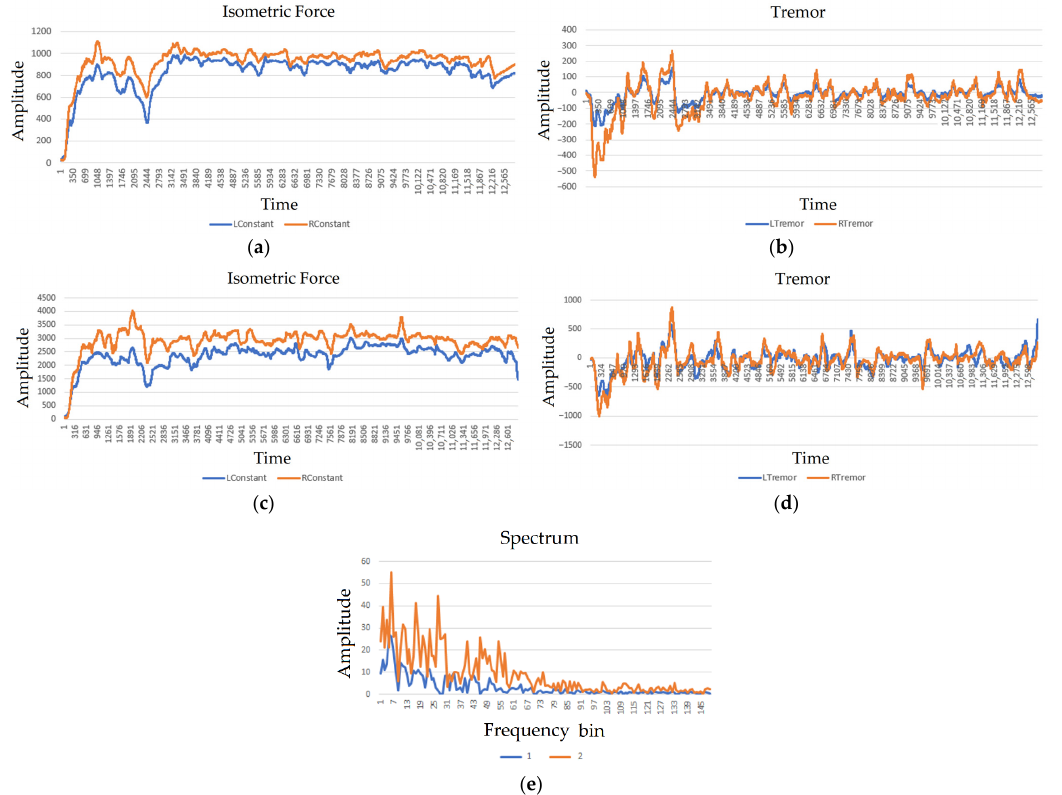
Figure 9. Results of measuring subsensory reactions of a healthy person: ( a ) left (LConstant)- and right (RConstant)-hand isometric effort (Test 1); ( b ) left (LTremor)- and right (RTremor)-hand subsensory reactions (Test 1); ( c ) left (LConstant)- and right (RConstant)-hand isometric effort (Test 2); ( d ) left (LTremor)- and right (RTremor)-hand subsensory reactions (Test 2); ( e ) spectral characteristics of hand subsensory reactions for tests 1 and 2.